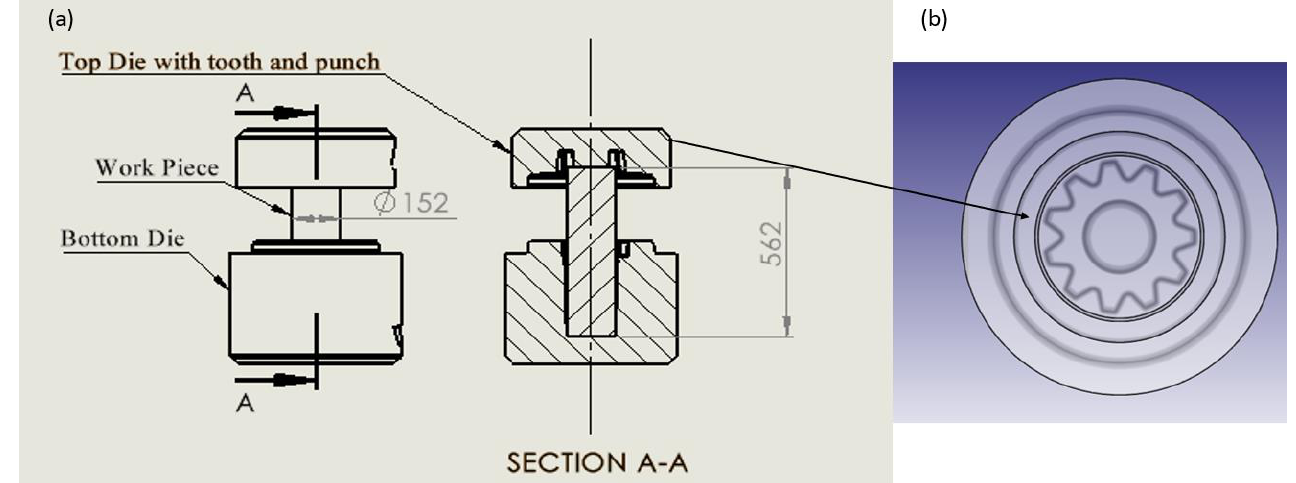
Figure 15. ( a ) Schematics of near-net-shape forging, ( b ) Top die with gear teeth and punch. Dimensions in mm.